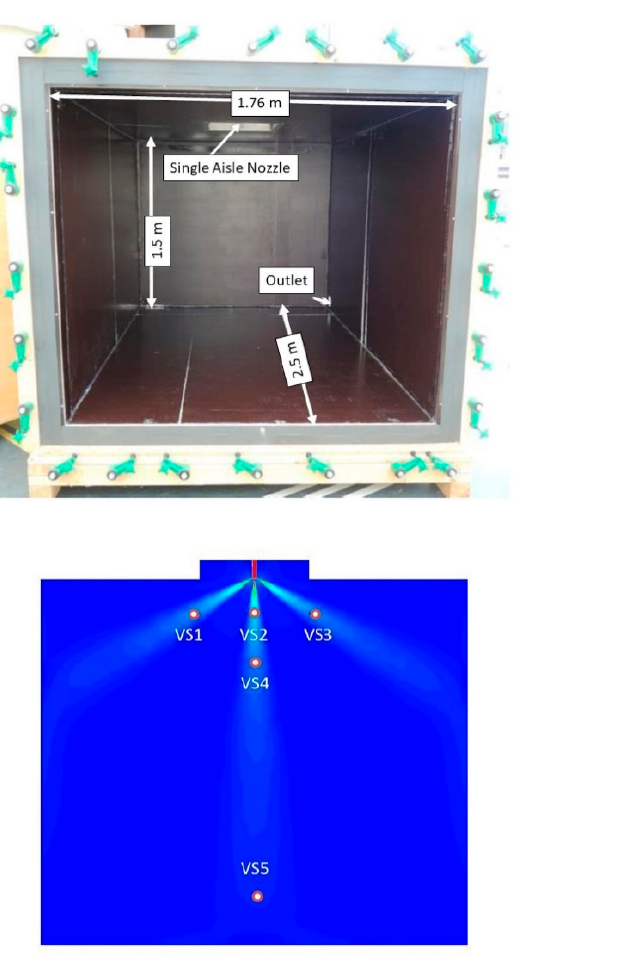
Figure 2. Prototype of a box demonstrator with single aisle cavity and nozzle ( top left ), CAD model of the prototype box demonstrator ( top right ), simulation result, and anemometer location ( bottom left ), validation result in m/s ( bottom right ).